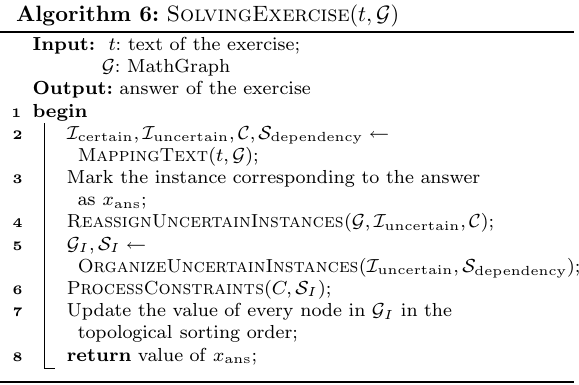
Algorithm 6: SolvingExercise ( t,